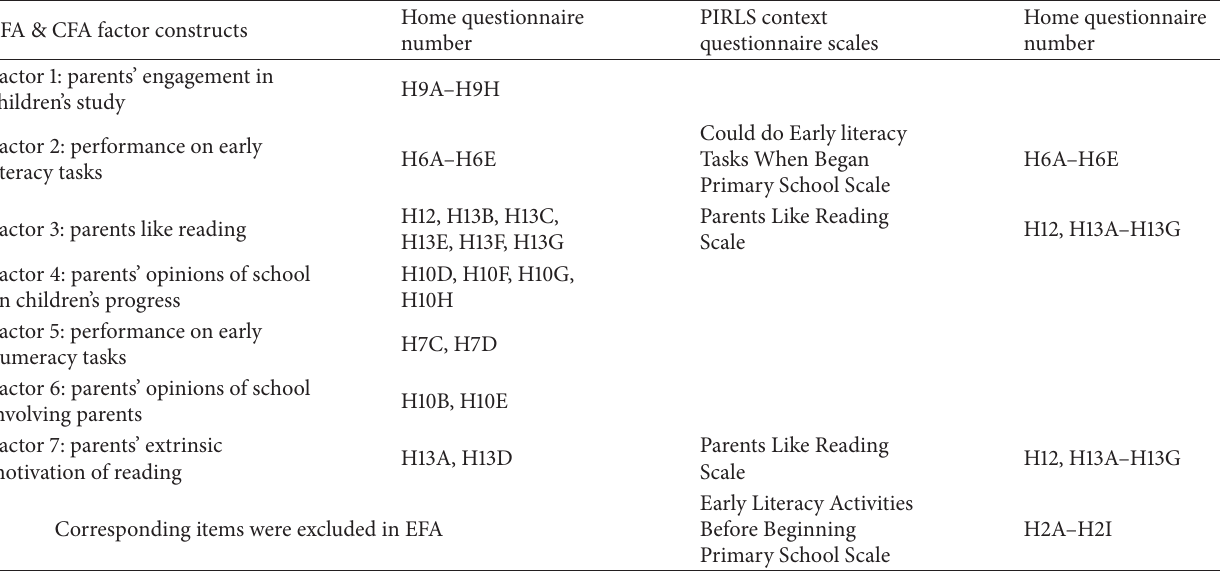
Table 6: Factor structure of the present study and PIRLS context questionnaire